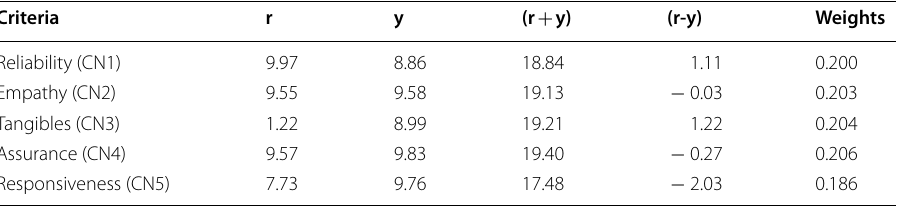
Table 7 Influences and weights of criteria for the customer needs